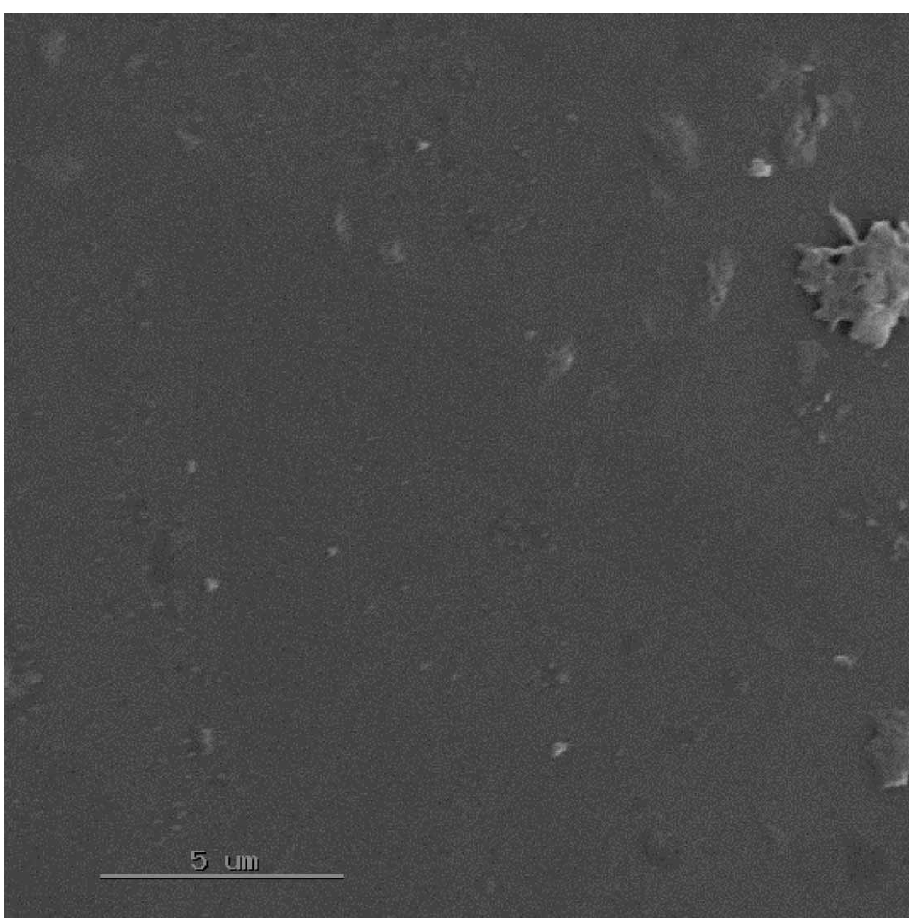
FIGURE 7 SEM image for untreated sample of n -Si with scale of 5 m